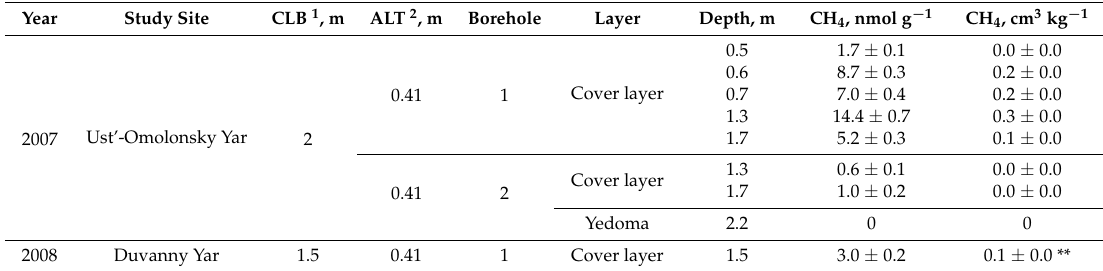
1 Depth of Cover Layer bottom; 2 active layer thickness, based on CALM data; * uncertainty values recalculated from the average measured uncertainties in the subset; ** uncertainty associated with chromatographic measurements recalculated from the average measured chromatographic uncertainties in the